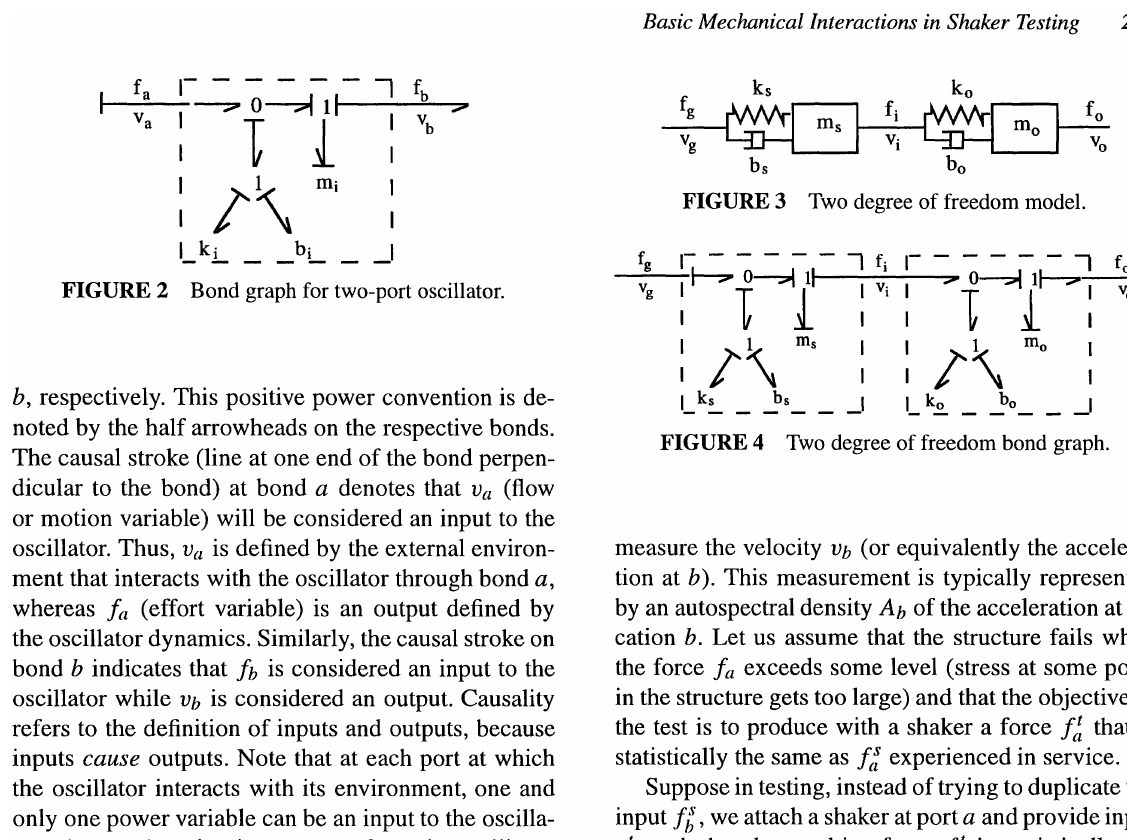
FIGURE 3 Two degree of freedom model.